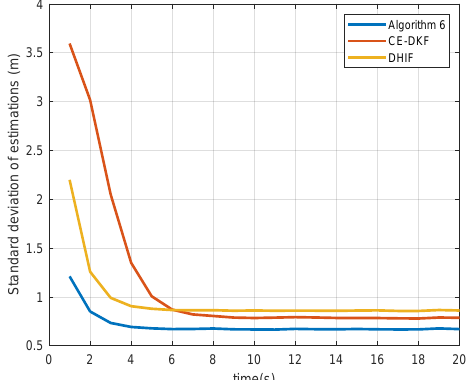
Figure 5. Standard deviation of estimations ( Q = Q 2 ).